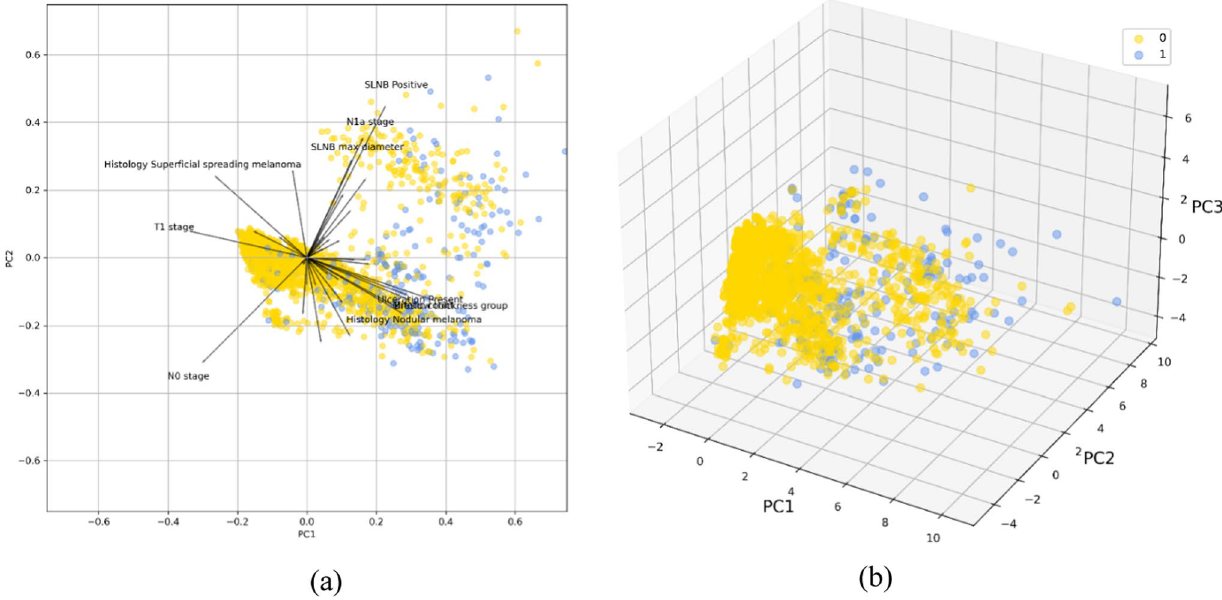
Fig. 1 Grade of separability of the two survival classes in a 2 dimensions, b 3 dimensions principal components projections. The original fea- tures with the largest coefficients in the first two principal components are also shown